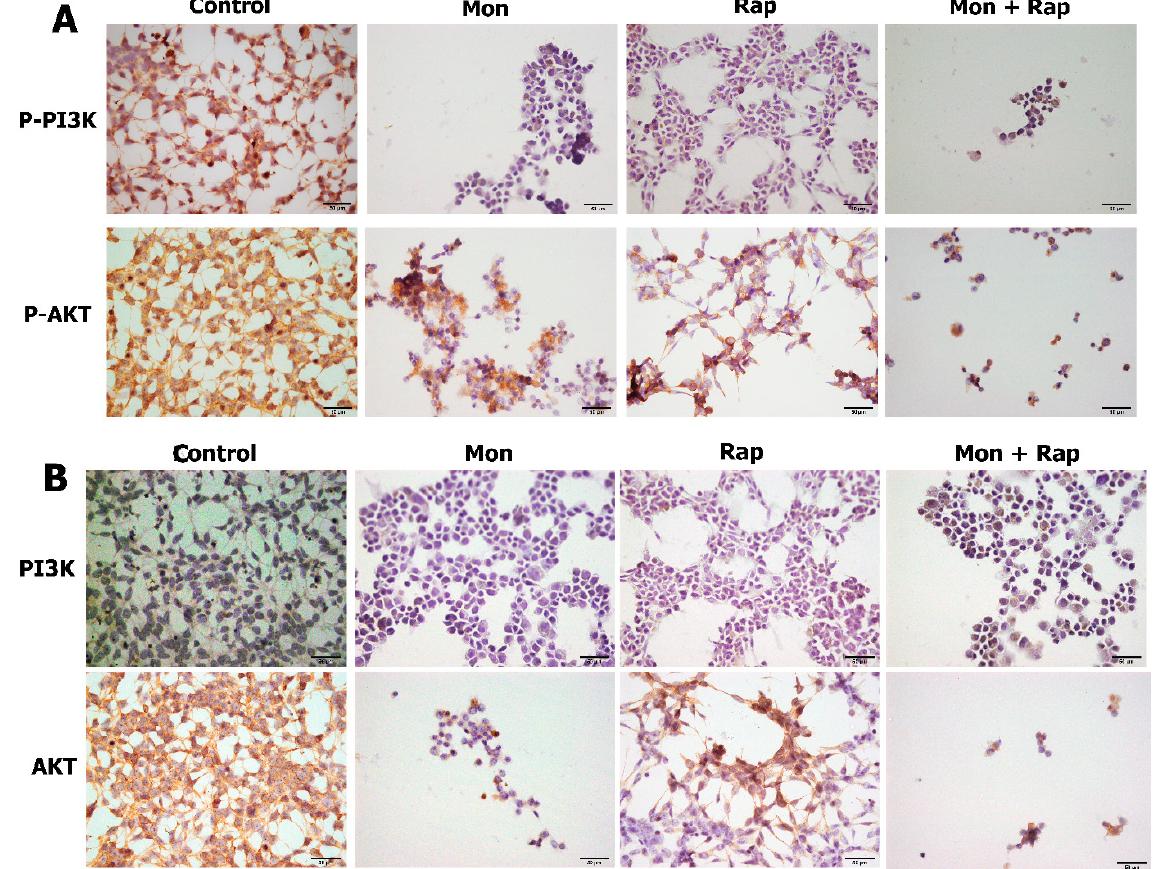
Figure 3. Immunohistochemical investigation of the effects of single and combined doses of mon and rap on PI3K and AKT expression in SH-SY5Y cells. ( A ) p-PI3K and p-AKT expression in different groups. ( B ) PI3K and AKT expression in different groups. p-AKT/AKT and p-PI3K/PI3K were expressed in the cytoplasm, cell membrane, and cytoplasmic extensions (brown) of SH-SY5Y cells. Bar: 50 µm.